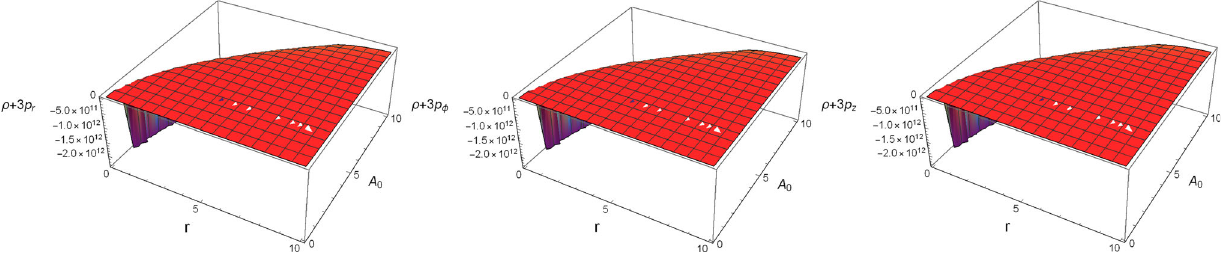
Fig. 31 Here, the graphical behavior of (ρ + 3 p r ) (MeV/fm 3 ) , (ρ + 3 p φ ) (MeV/fm 3 ) and (ρ + 3 p z ) (MeV/fm 3 ) w.r.t r (km) with m = − 3, n = 2 and α = − 0 . 01 shown in this panel. We can clearly see that the SEC violated throughout the region for r >